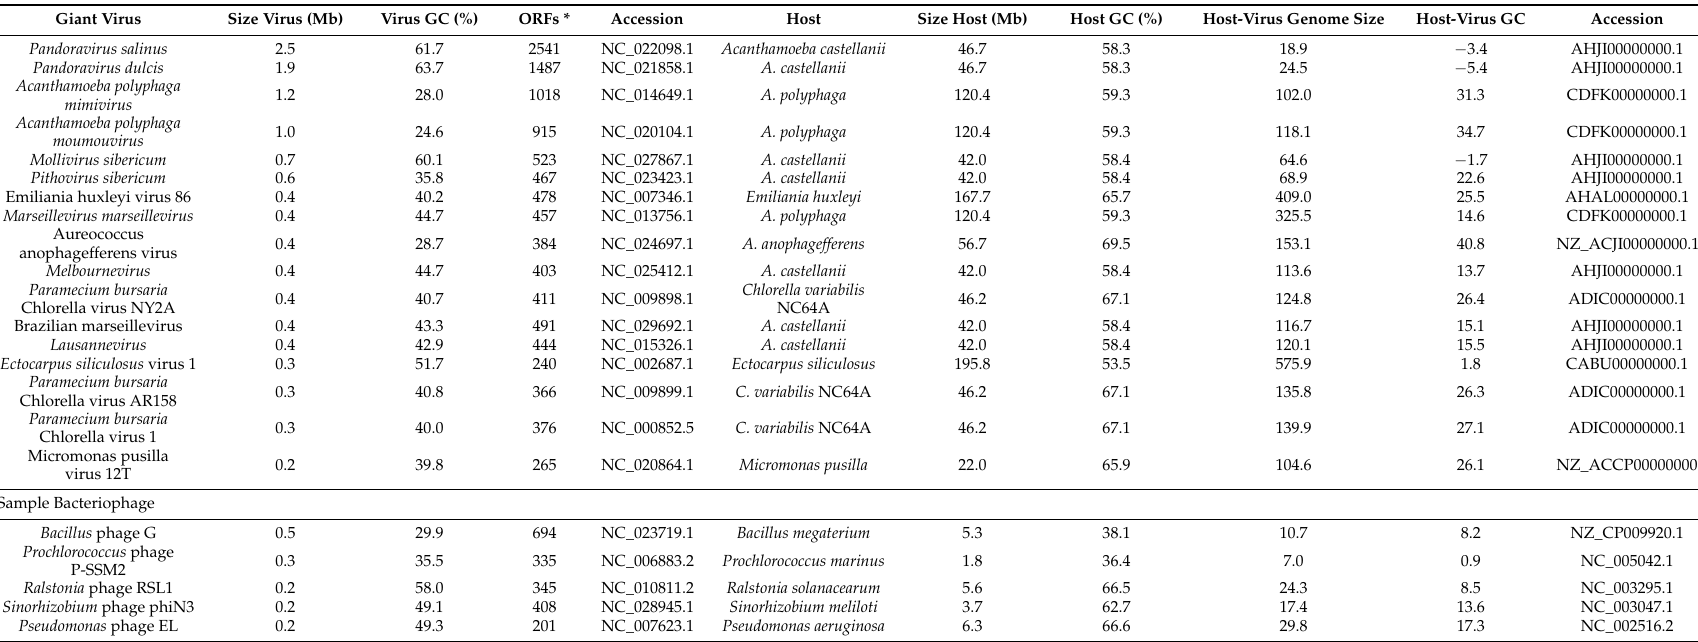
Table 1. Comparison of host and viral genome size and GC content. All data was collected from the NCBI